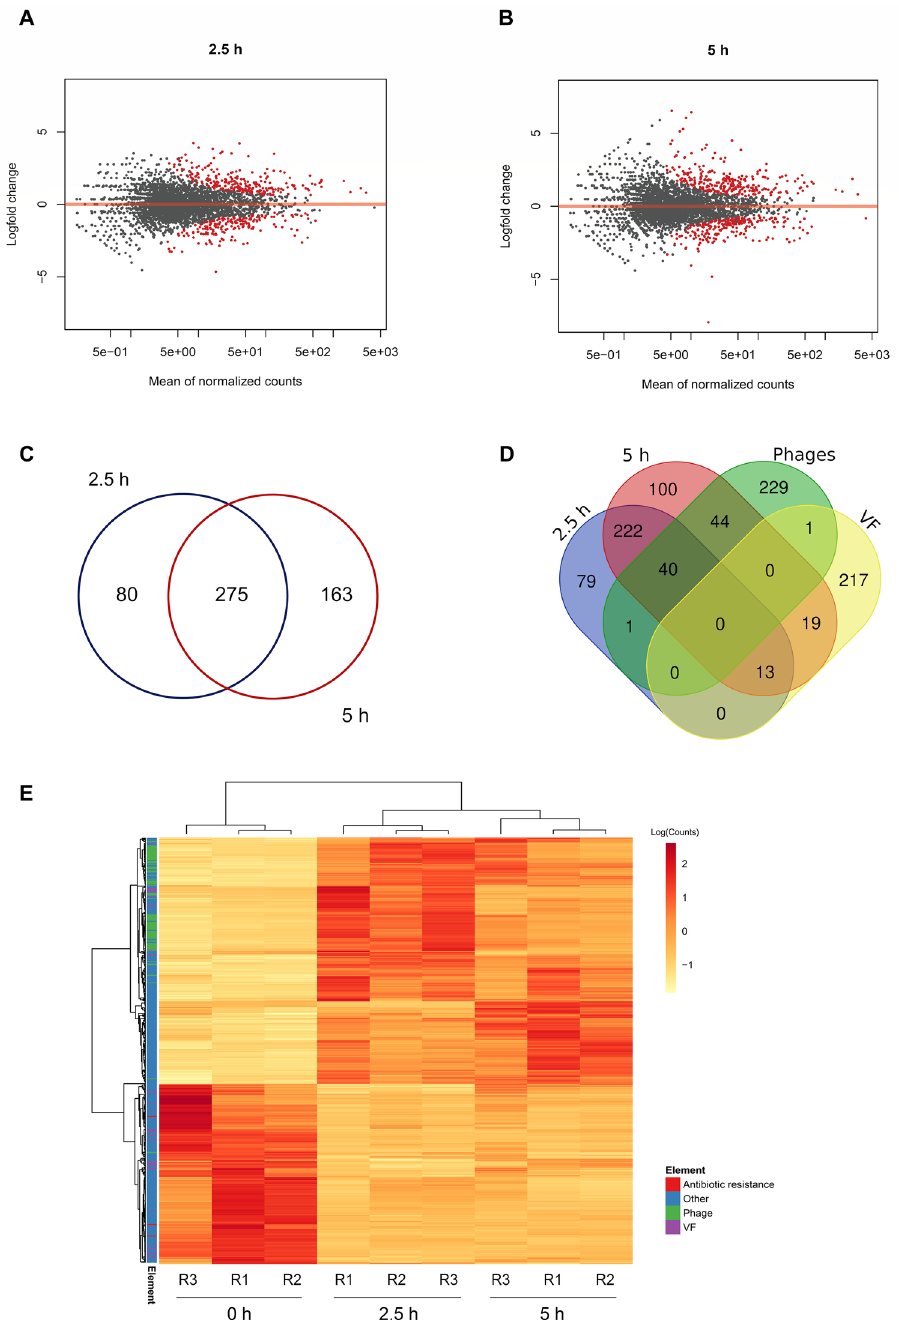
Figure 3. Differential expression analysis in PaeAG1 exposed to ciprofloxacin compared to initial time 0 h. Selection of DEGs according to adjusted p -value (p < 0.05) and logFC (logFC < − 1 or logFC > 1) at 2.5 h ( A ) or 5 h ( B ) post-exposure to antibiotic. ( C ) Venn diagram showing the comparison of DEGs in the two evaluated times, with 275 shared genes (intersection) and total 518 genes at any time (union) with respect to time 0 h (control). More details in Table 1. ( D ) Venn diagram showing the comparison of DEGs and phage genes or virulence factors (more details in Table 2). ( E ) Heatmap of normalized counts and gene clustering of the total 518 DEGs at the three evaluated time